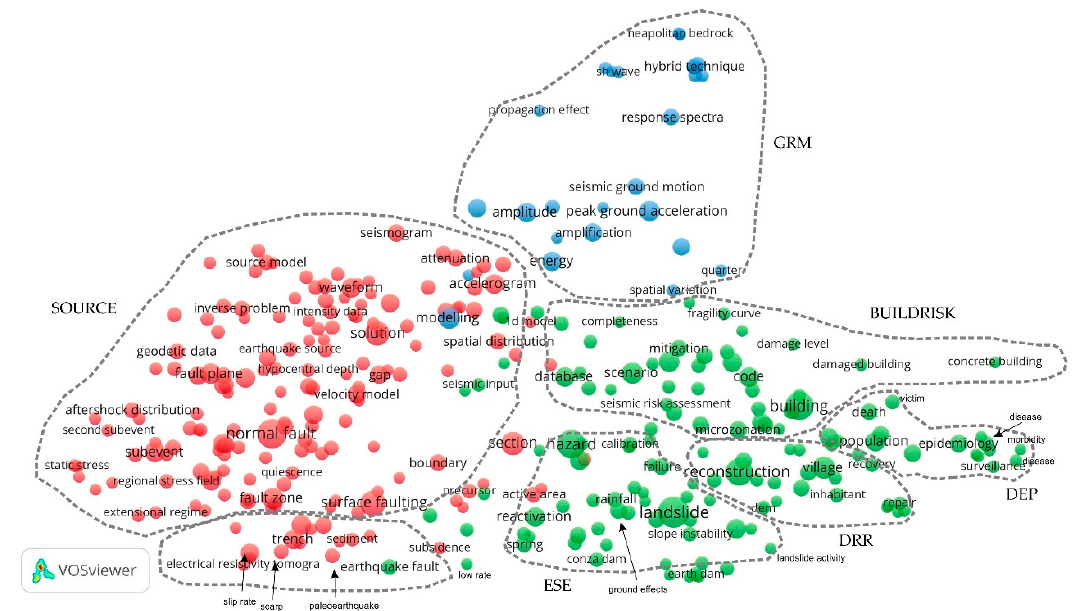
Figure 5. Network visualization by VOSviewer of IR_BASE_ENG database. For each term, the size of the term’s label and the size of the term’s circle depend on the number of occurrences. The map shows the three main clusters. The first two wider clusters may be divided into some subclusters. For example, the green cluster can, in turn, be divided into four main subclusters whose terms and “boundaries” are roughly drawn manually in the map. Taken overall, the map identifies seven main research fields on the 1980 earthquake. To improve the readability of the map, we added manually some names of terms.